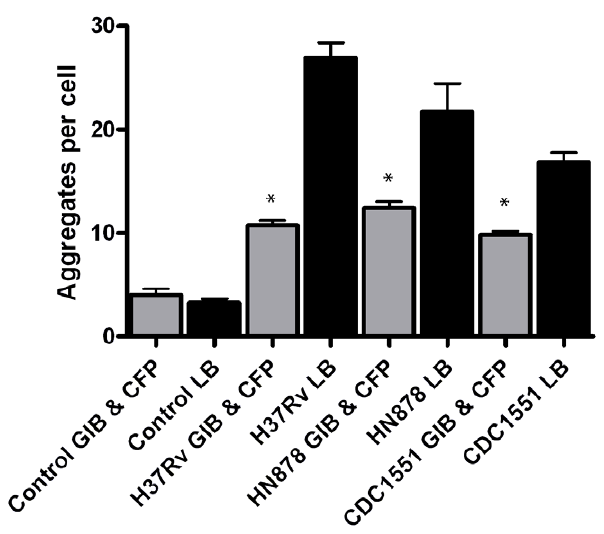
Figure 5. LR aggregation produced by gamma-irradiated Mtb strains and CFP does not equal aggregation observed with live bacteria. Data from figures 3 and 4 were combined for comparison with LR aggregation data from live bacteria experiments. Less than 55% of the aggregation observed with live Mtb infection is detected when CFP or gamma-irradiated strains H37Rv, HN878 and CDC1551 are used (*p-value , 0.001, 0.01 and 0.05, respectively). (GIB- gamma irradiated bacteria; LB- live bacteria; CFP- culture filtrate